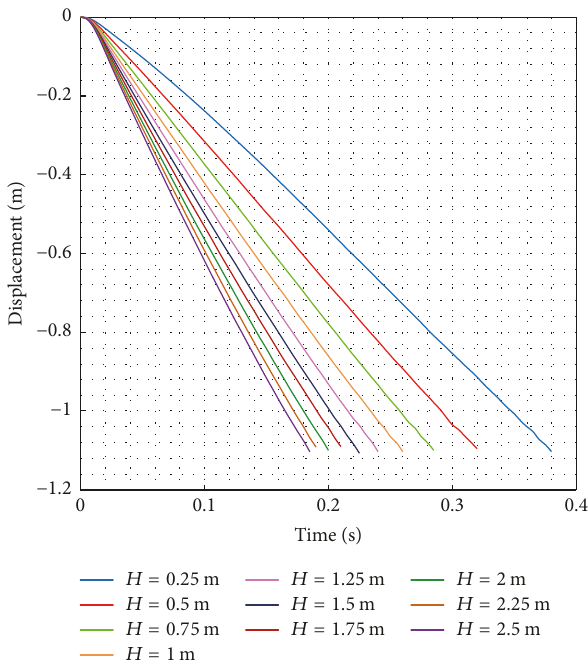
Figure 13: Displacement-time graph of the conical pounder with different drop heights.